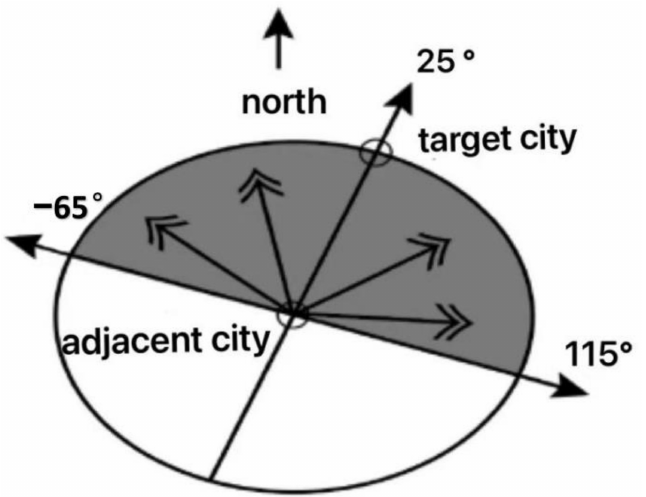
Figure 5. Spillover effects of air pollution based on wind direction. It means that the adjacent city’s air pollutants can significantly influence the target